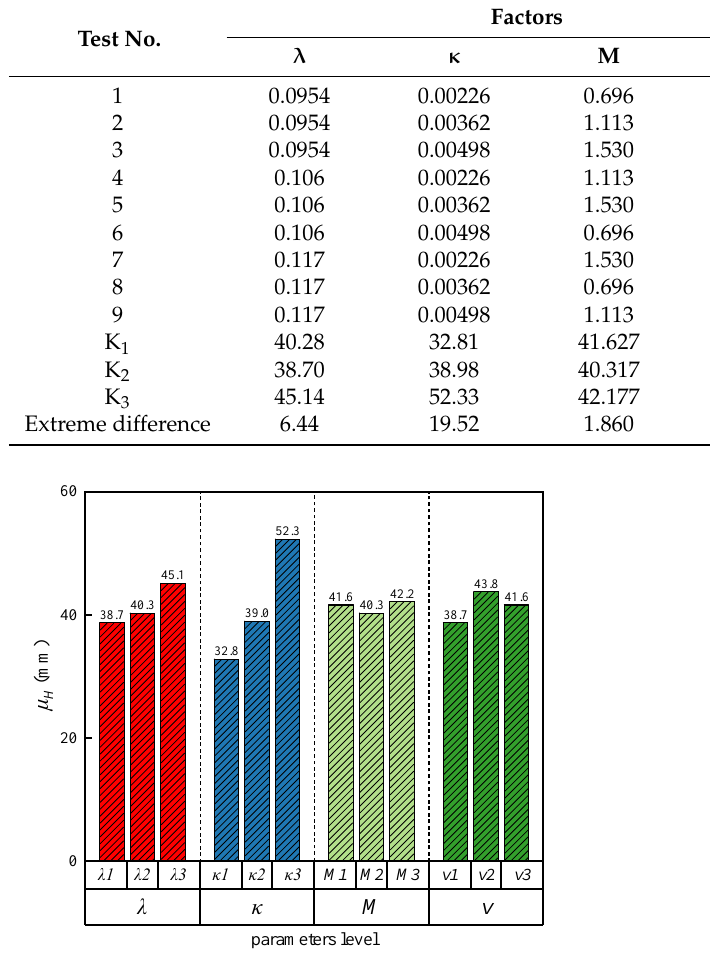
Figure 8. Mean values of surface settlement at different levels due to different parameters.